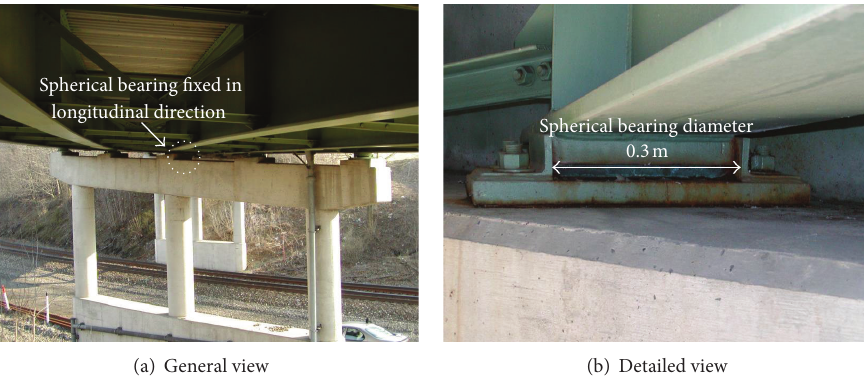
Figure 3: Spherical bearing system.